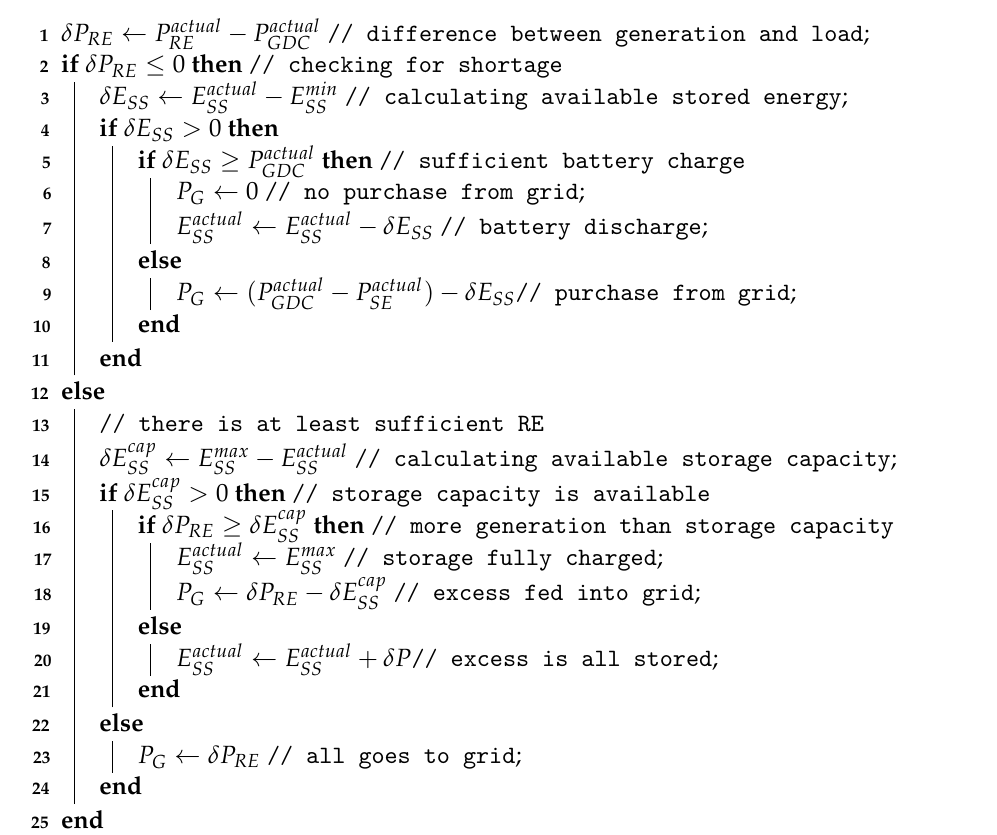
Algorithm 1: Management of RE generation excess or